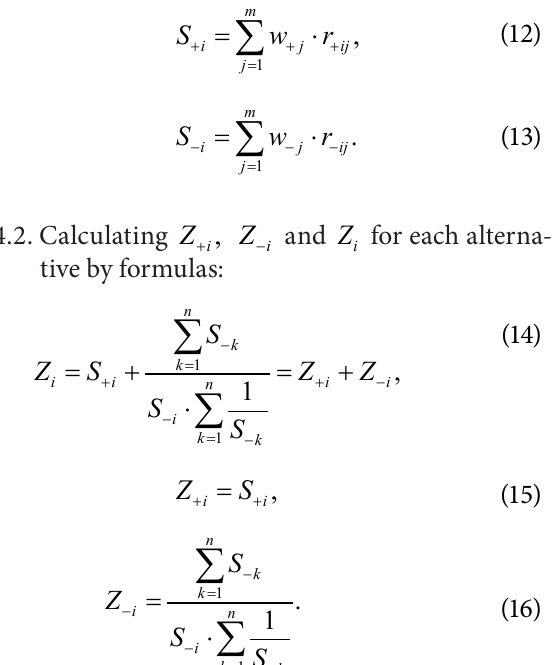
Table 13. Weighted normalized decision